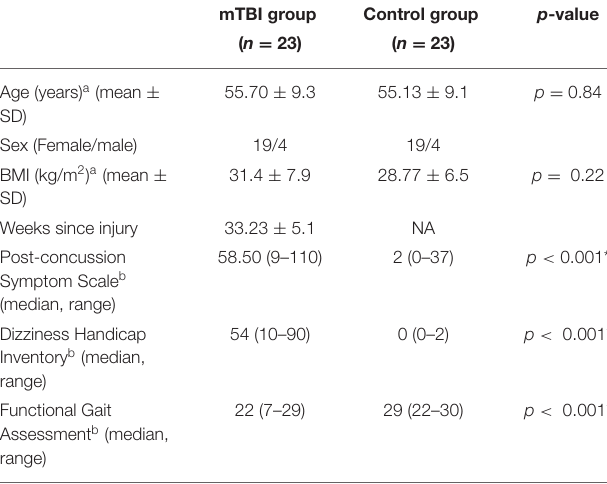
TABLE 1 | Participant